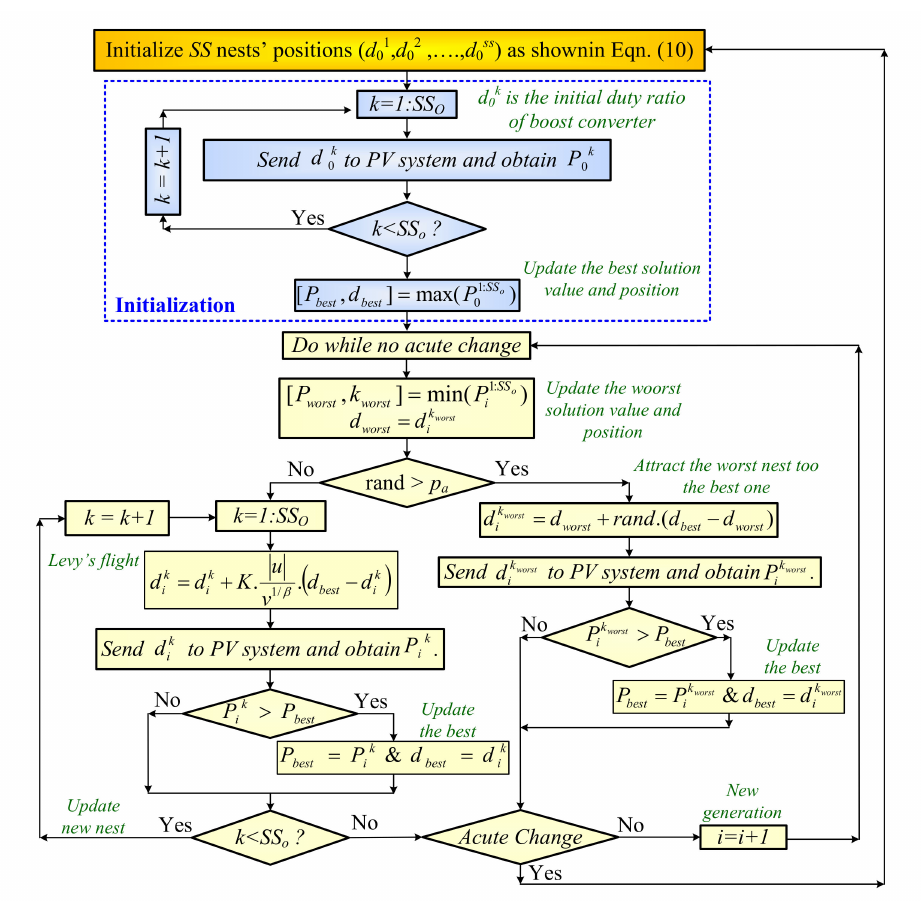
Figure 5. Improved Cuckoo search algorithm in MPPT of PV